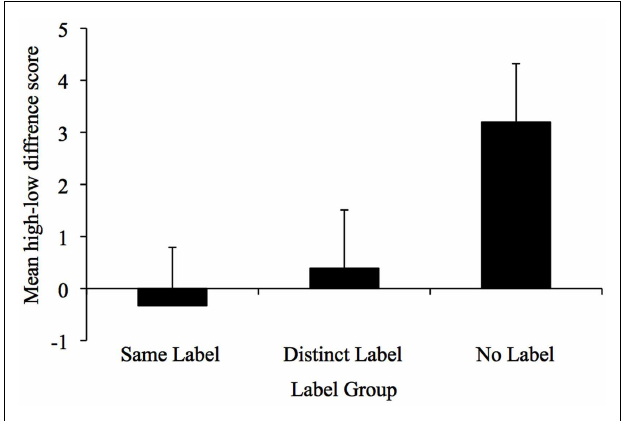
FIGURE 3 | Mean high-low difference scores as a function of label